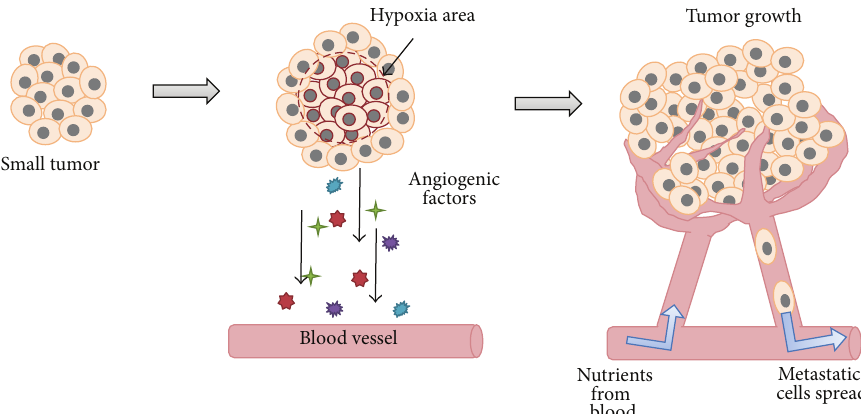
Figure 1: Angiogenesis is the process through which new blood vessels form and grow. Tumor cells activated by a lack of oxygen (or a gene mutation) release, among other things, angiogenic factors that attract inflammatory and endothelial cells and promote their proliferation. The endothelial cells that form existing blood vessels respond to angiogenic signals in their vicinity by proliferating and secreting proteases, which break open the blood vessel wall to enable them to migrate toward the tumor site. Proliferating endothelial cells then organize themselves into new capillary tubes by altering the arrangement of their adherence-membrane proteins. Finally, the capillaries provide a continuous blood flow that sustains tumor cell metabolism and sets up escaping avenues for metastatic tumor